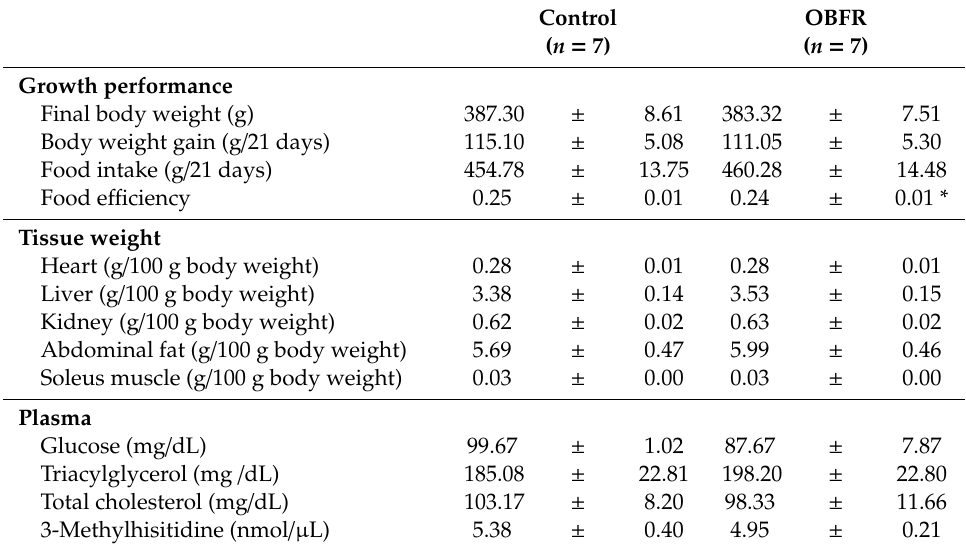
Table 2. E ff ects of feeding OBFR on growth performance and tissue weights of rats. Control